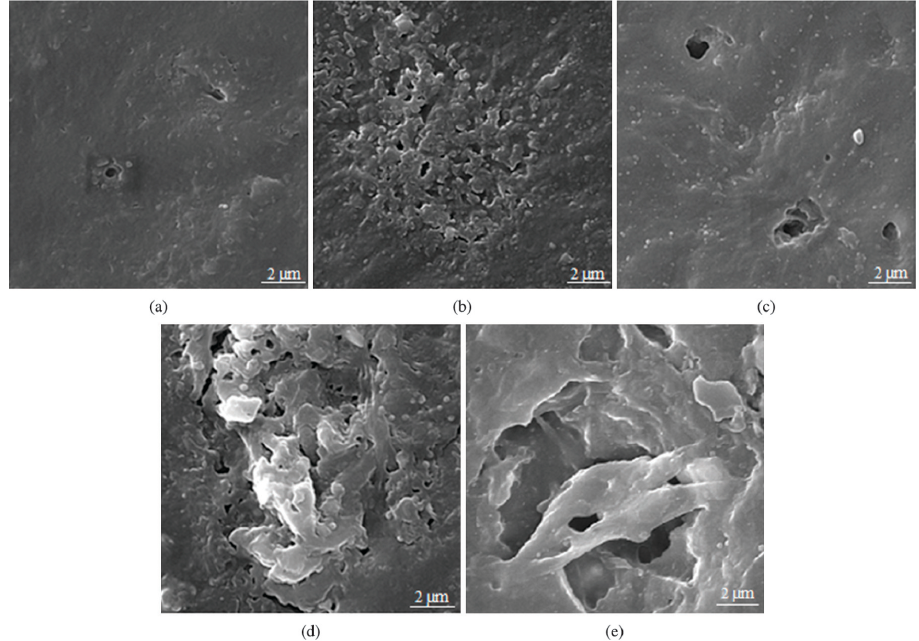
Figure 13. SEM images of PP nano-composite samples after 500 h of UV irradiation. ( a ) Pure PP, ( b ) PP5Ti, ( c ) PP10Ti, ( d ) PP30Ti, and ( e ) PPDTi [69].